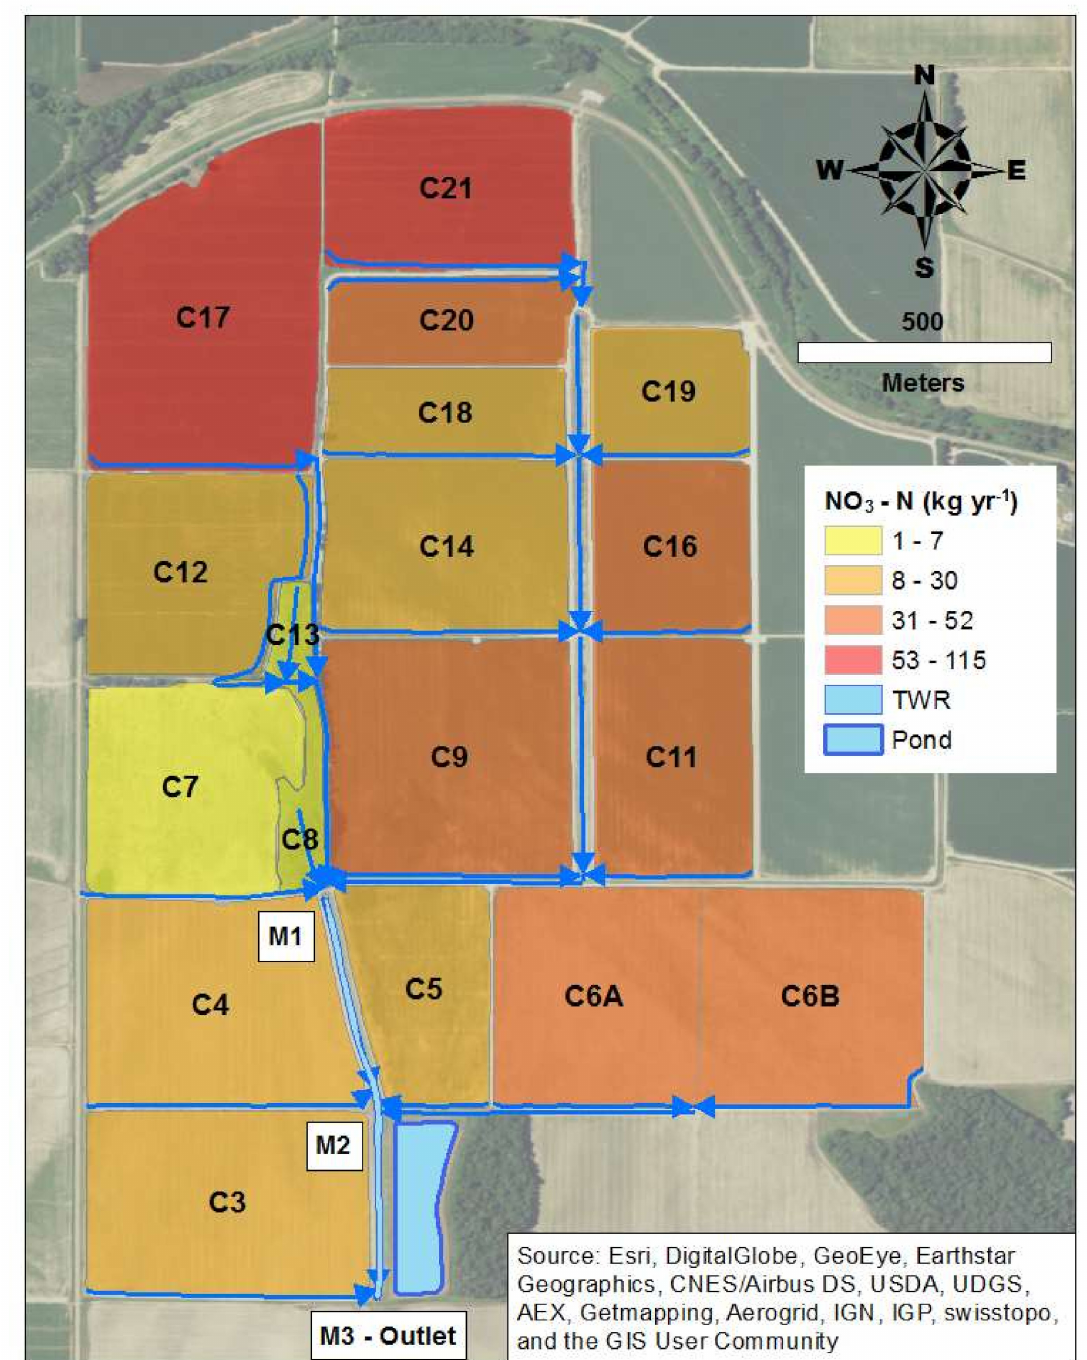
Figure 4. Map of the study area showing the average annual NO 3 –N load in the simulated watershed. The blue arrows represent the runo ff flow direction towards the outlet. (M1: TWR inlet; M2: TWR mid-canal; M3: TWR outlet; labels within fields indicate the subwatershed identification used by the AnnAGNPS